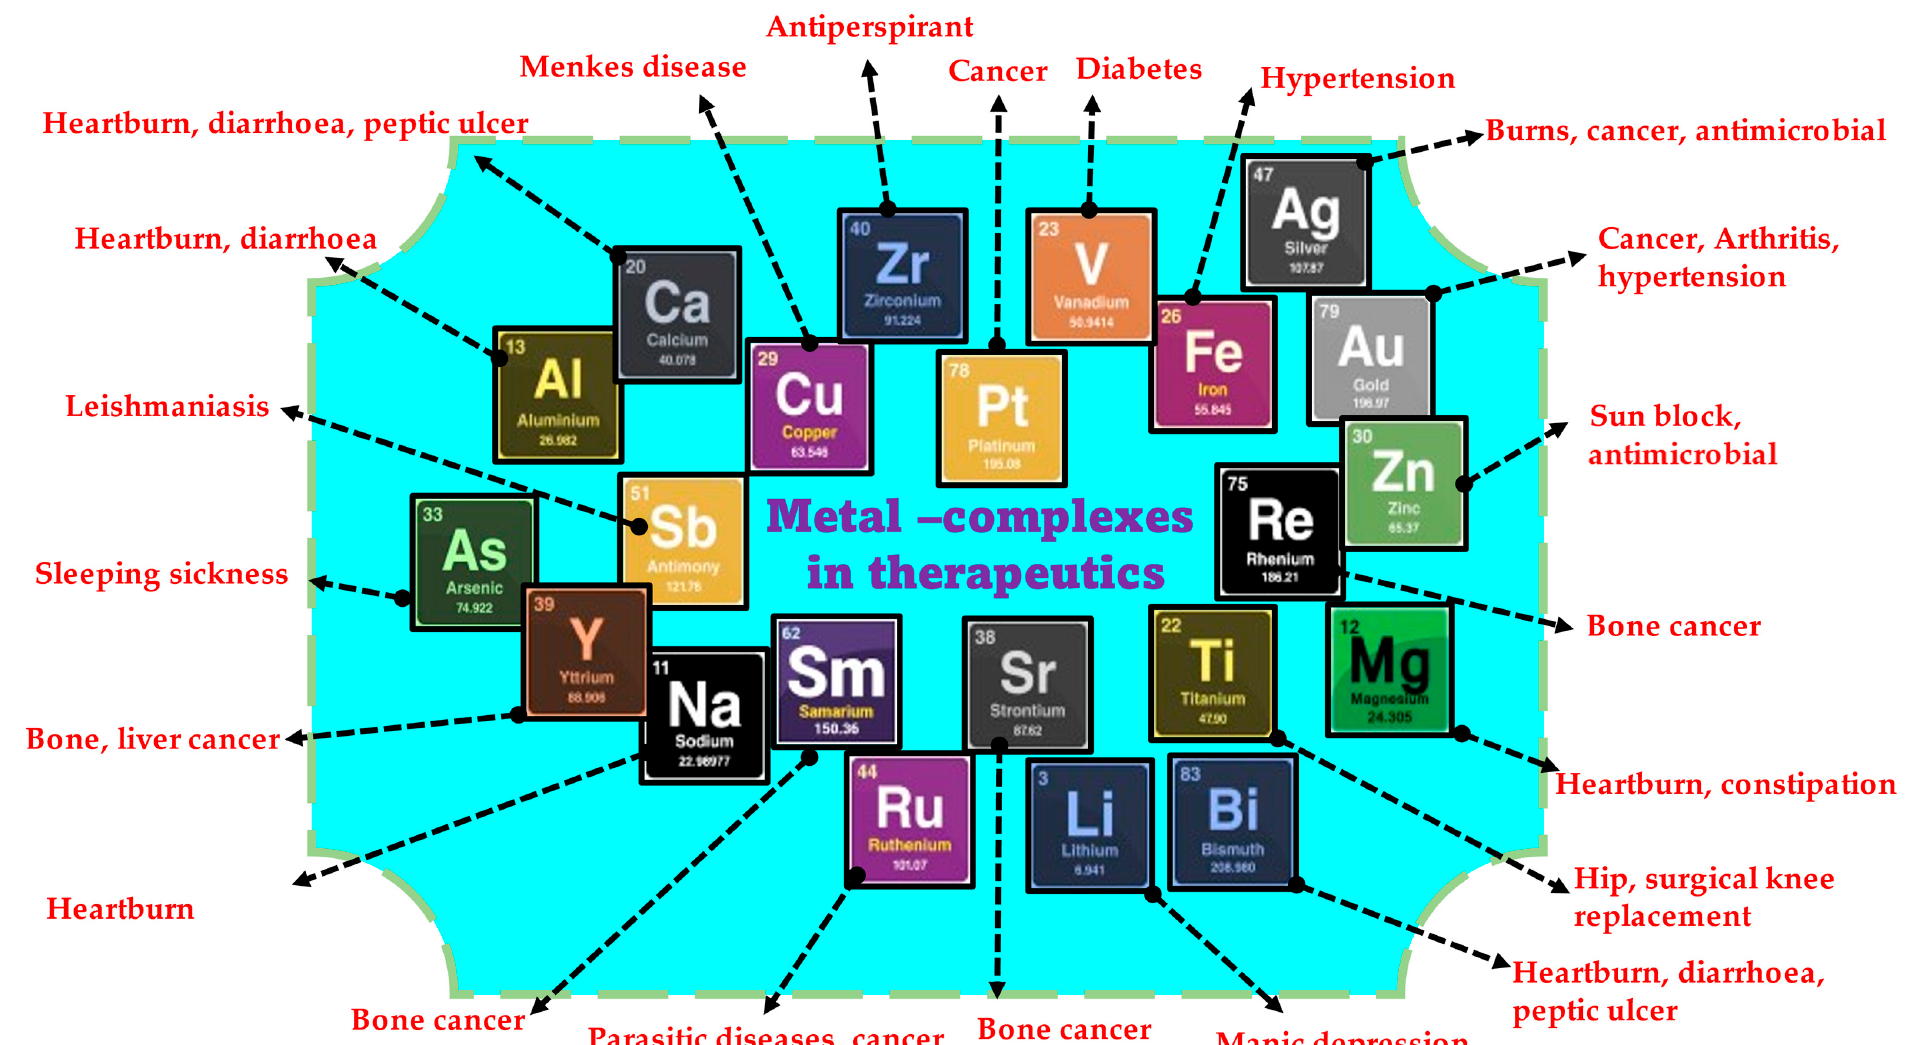
Figure 1. Validated medicinal properties of various metal/metal